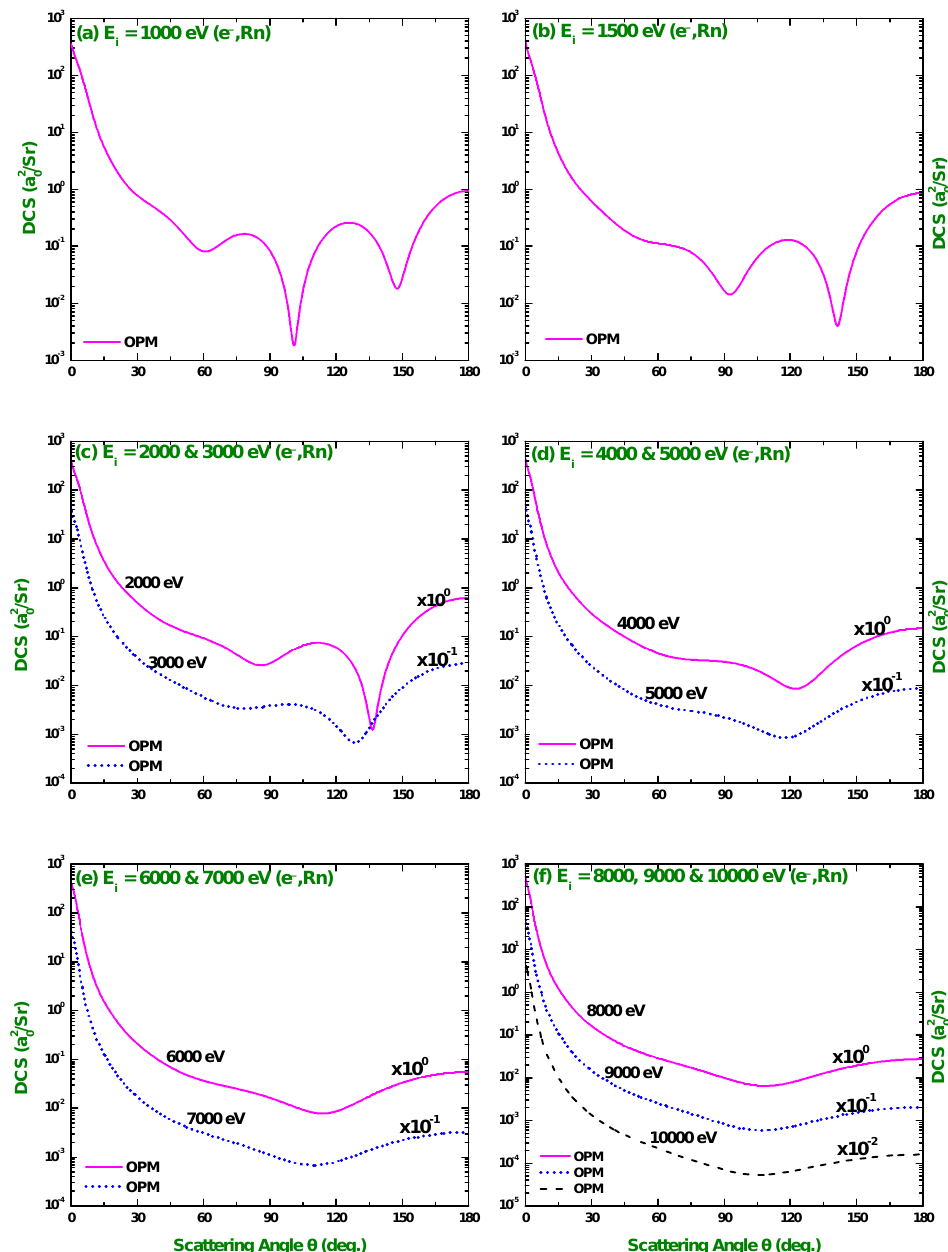
Figure 9. Angular dependence of the differential cross section of electrons scattering from 222 Rn at 1 ≤ E i ≤ 10